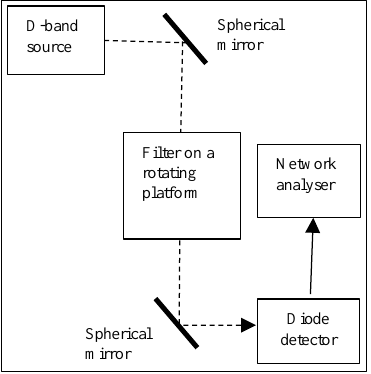
FIG. 6. Schematic of experimental